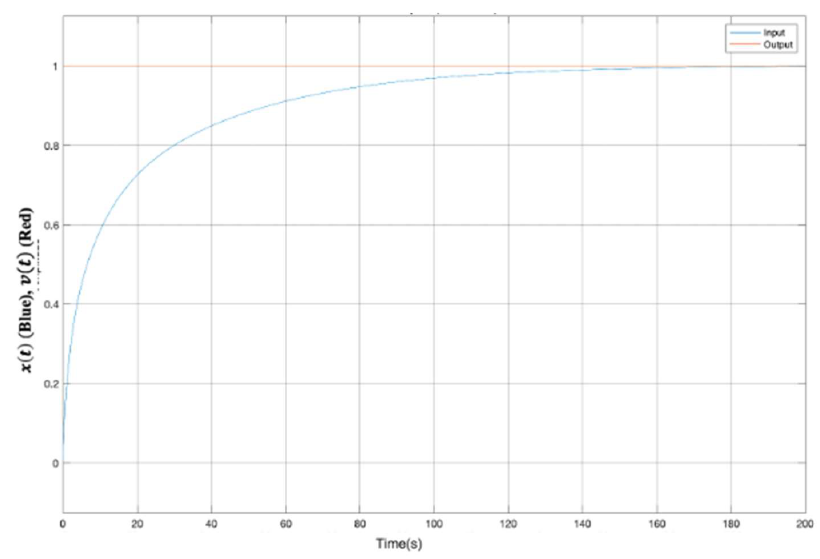
Figure 7. Response to a Step Input with Techniques 2 and 3.